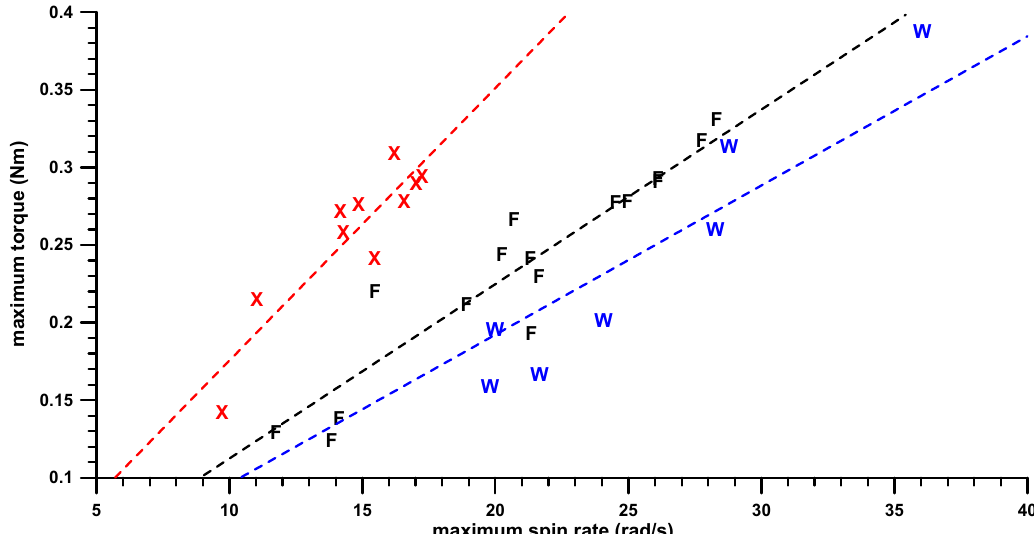
Figure 1. Maximum torque against maximum spin rate; dashed line = gradient of a through-origin fit (times 100 = average bowling potential of each group): X = fast bowlers, F = finger-spinners, W = wrist- spinners.